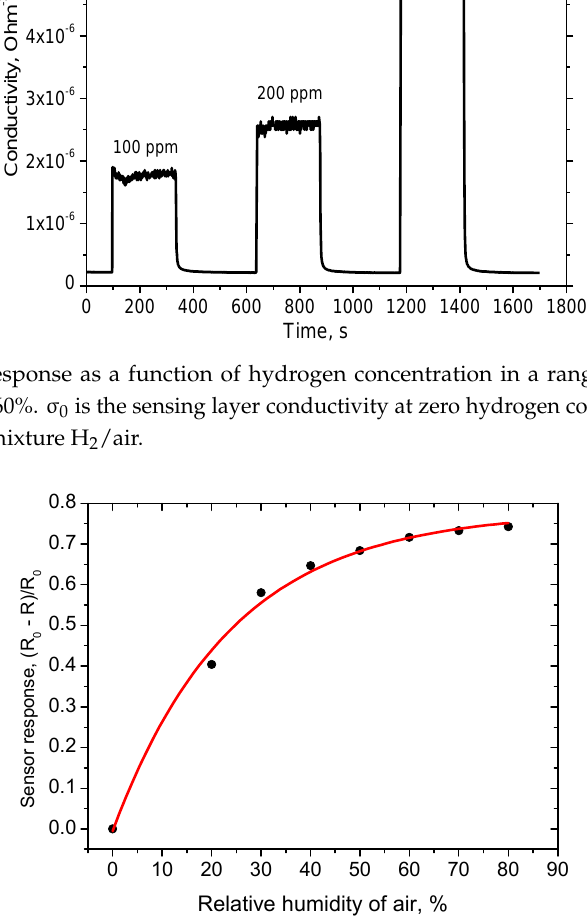
Figure 11. Relative change of resistance as a function of relative humidity. R 0 is the sensing layer resistance at zero humidity, R is the resistance in humid air.